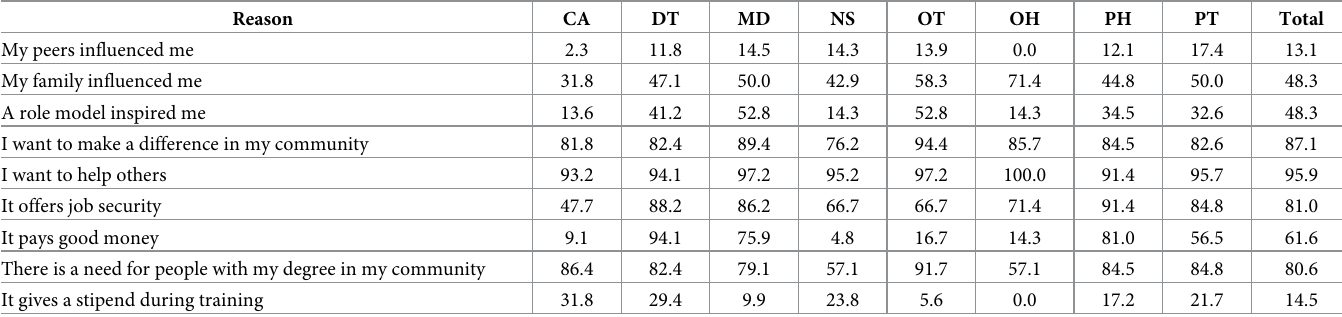
Table 3. Reasons for chosen